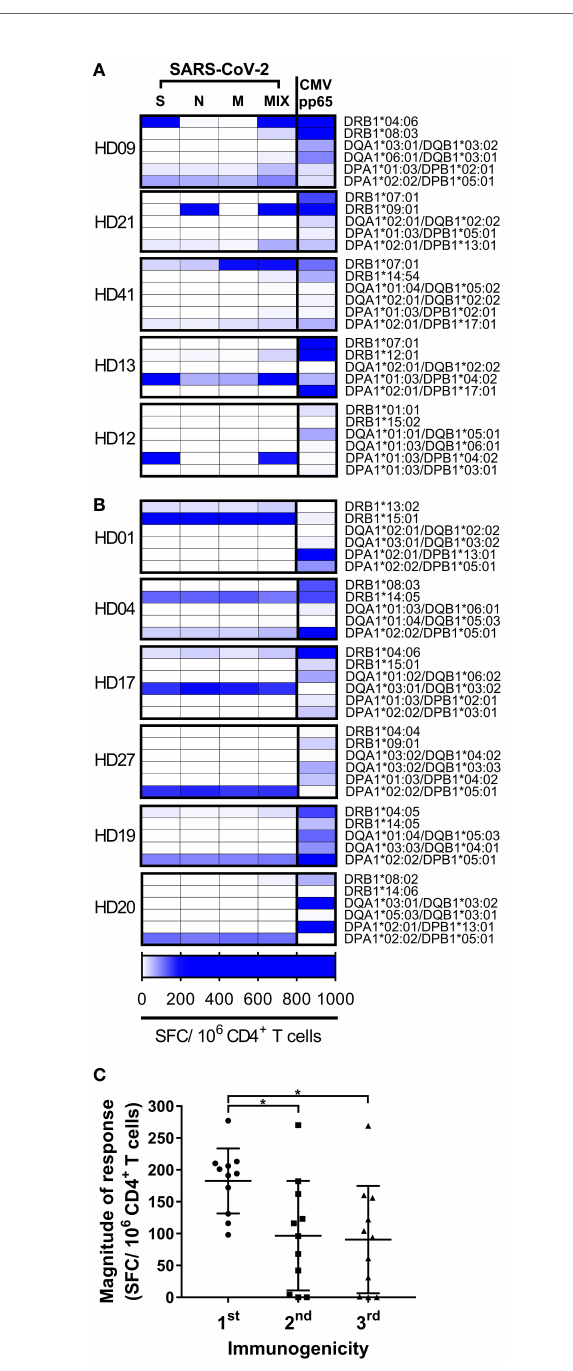
FIGURE 3 | CD4 + T cell responses by each HLA class II allotype to each SARS-CoV-2 antigen in each individual. (A, B) CD4 + T cell responses by an allotype were measured individually with spike (S), nucleocapsid (N), membrane (M), or CMV pp65, and with a mixture (MIX) of peptide pools of S, N, and M protein. High responses are highlighted at the blue end of the spectrum. (C) The order of immunogenicity indicates the order of highest response to S, N, or M among the responses by an allele that showed the strong response in an individual. Each dot represents a response by an allotype to a peptide pool of a protein. Data are shown as mean ± SD. Statistical analysis was performed using one-way ANOVA. *P < 0.05.